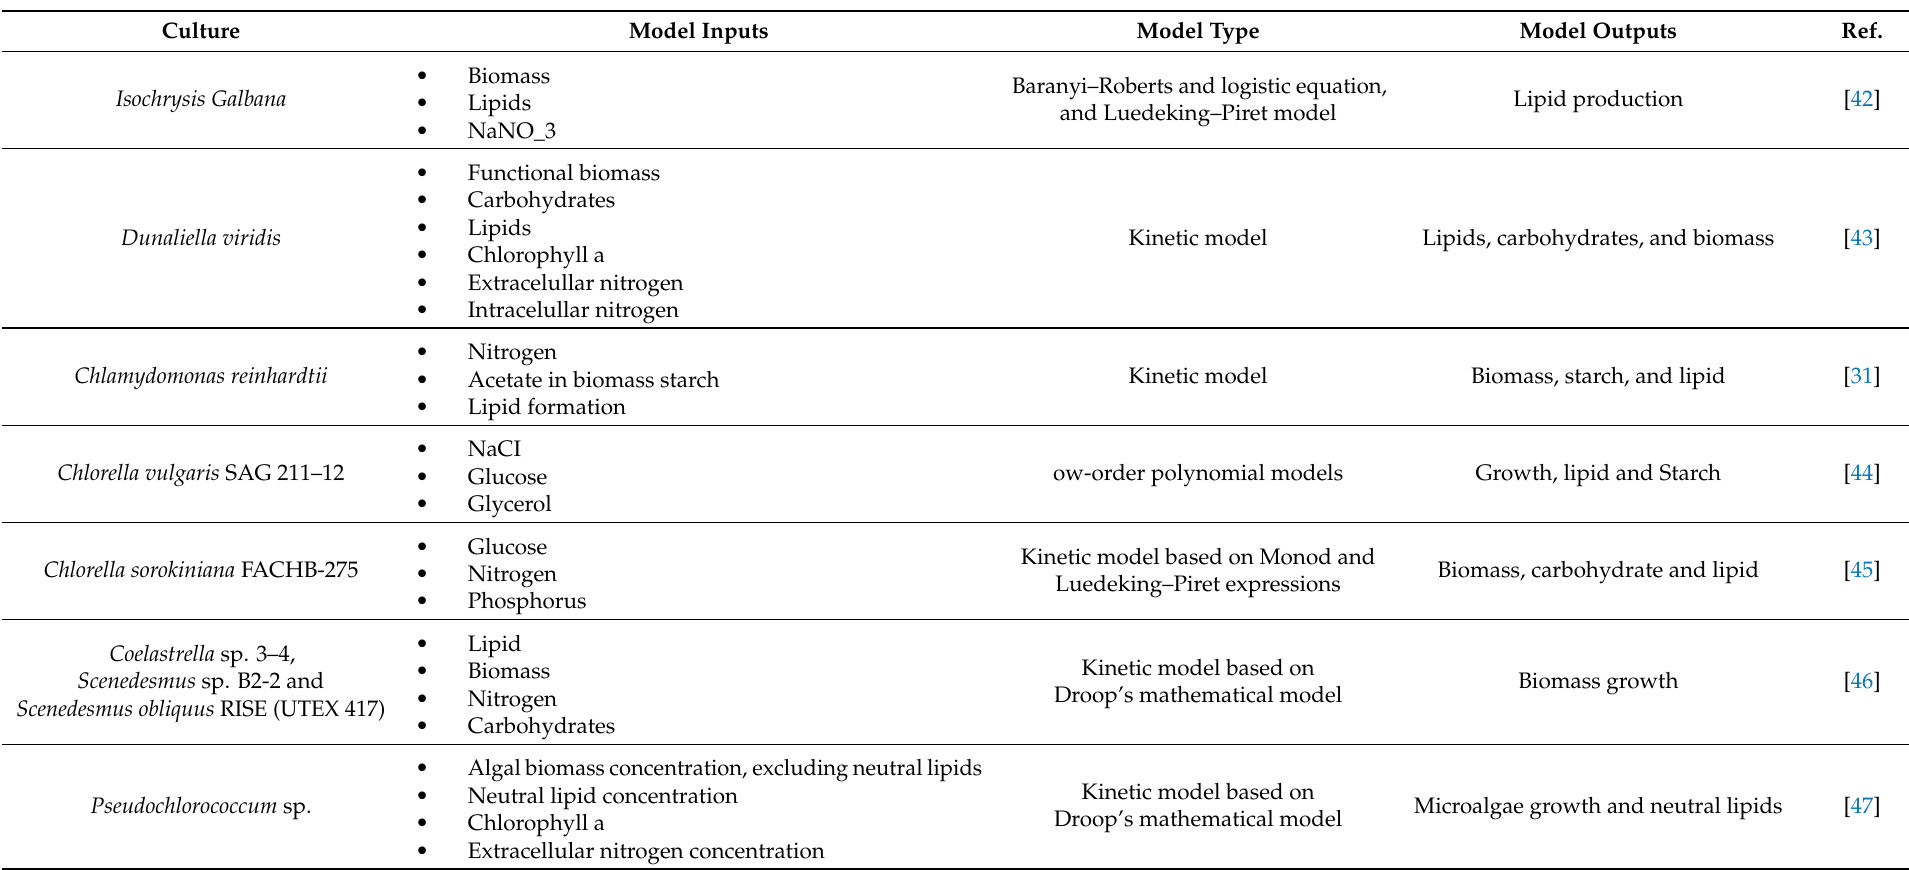
Table 7. Comparison of state-of-the art works and our